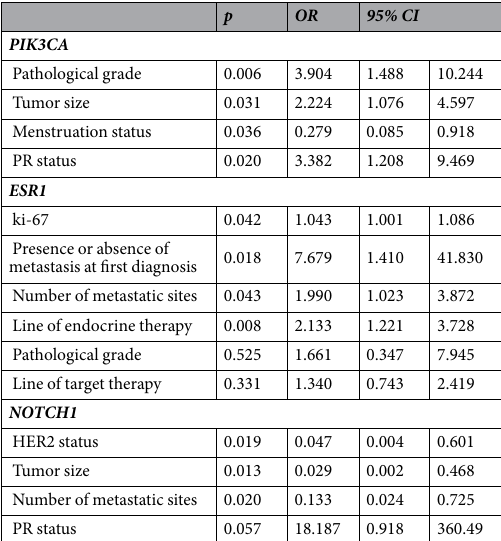
Table 4. Multivariate analyses of the associations between somatic mutations and clinical characteristics. PR progesterone receptor, HER2 human epidermal growth factor